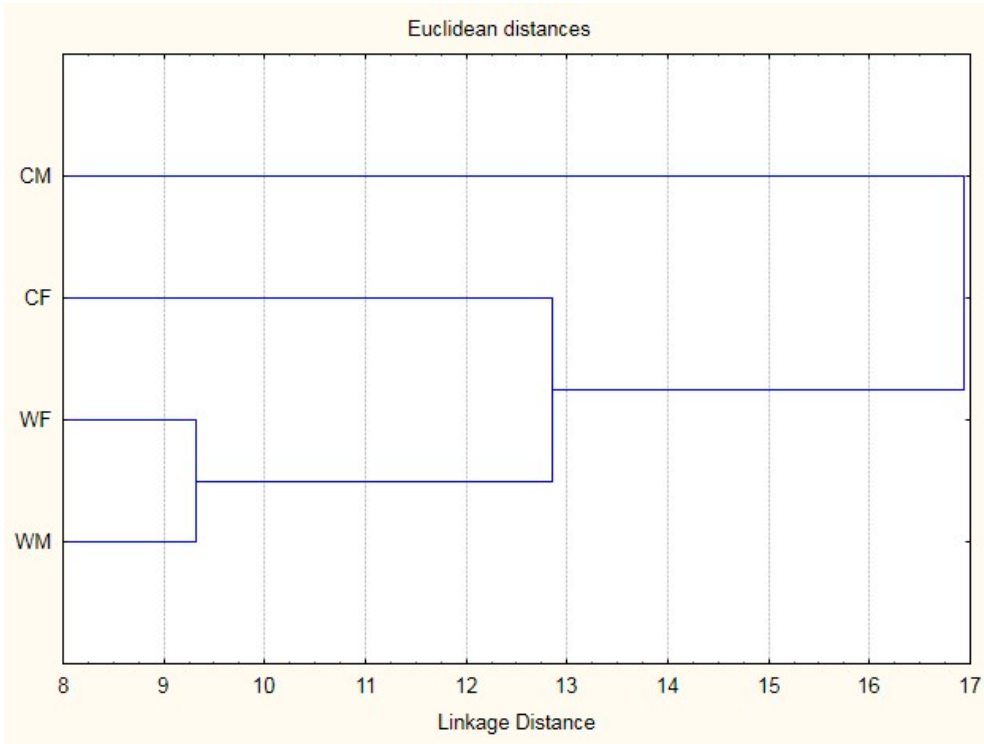
Figure 2. Cluster from Mahalanobis distances in Dormitator latifrons for both factors (sex and production system).